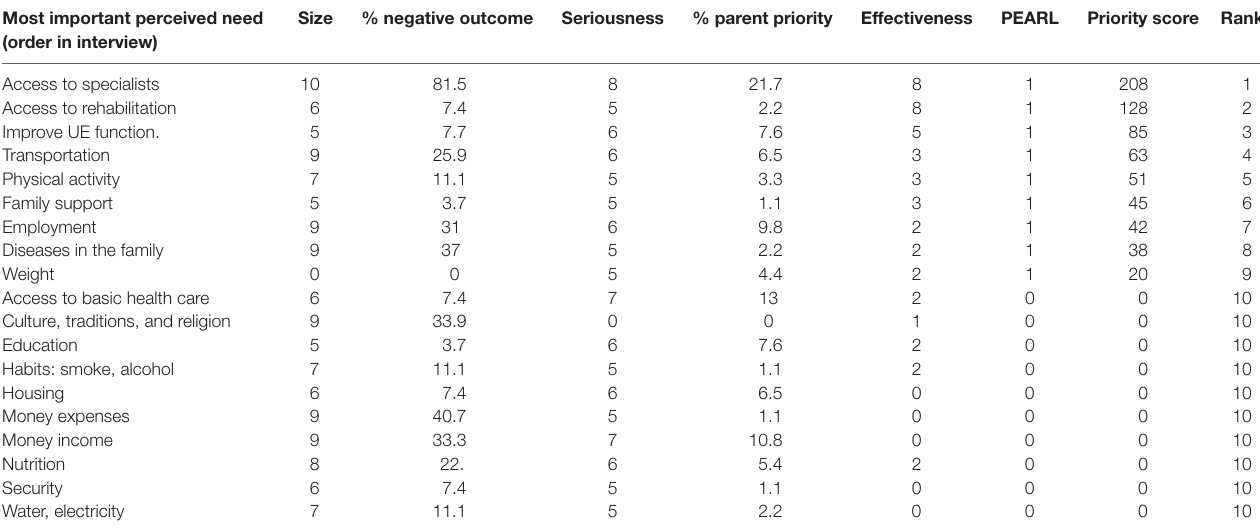
taBLe 3 | Prioritization of needs according to Hanlon method. most important perceived need (order in